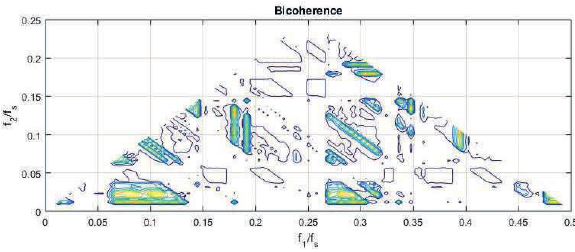
Fig. 9: Bicoherence of the state z of Fractional order System (16).